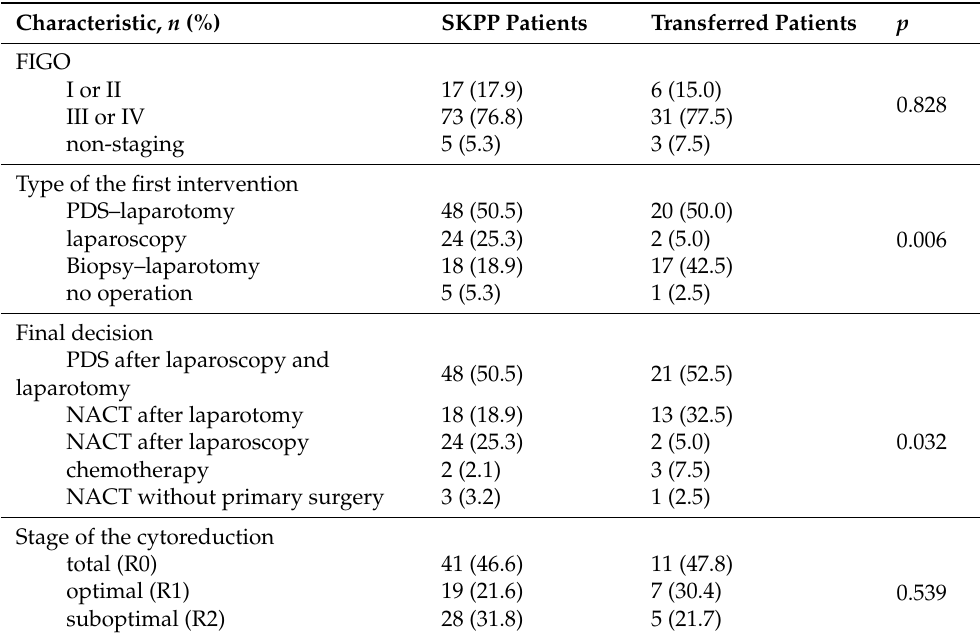
Table 2. Comparison of selected characteristics between patients from SKPP and those transferred from other